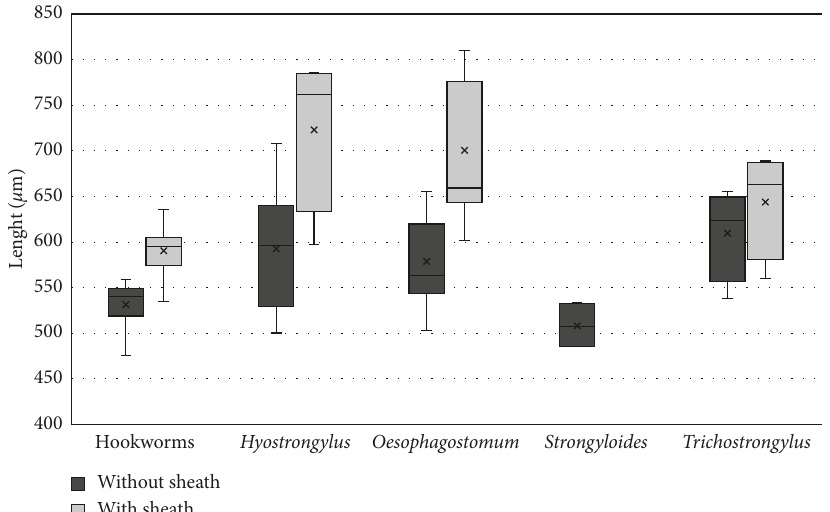
Figure 2: Box plots illustrating the length of filariform larvae of different parasites recovered from human and swine coprocultures by the Harada–Mori technique, with and without the sheath. Comparing the length averaged by ANOVA, the following results are obtained: in the sheath, hookworms vs. Trichostrongylus , p 0 . 166; hookworms vs. Oesophagostomum , p 0 . 001. Without the sheath, hookworms vs. (cid:31) Trichostrongylus , p 0 . 051; hookworms vs. Oesophagostomum , p 0 . 001. X on plot mean; transverse line on plot (cid:31) (cid:31) (cid:31) < <